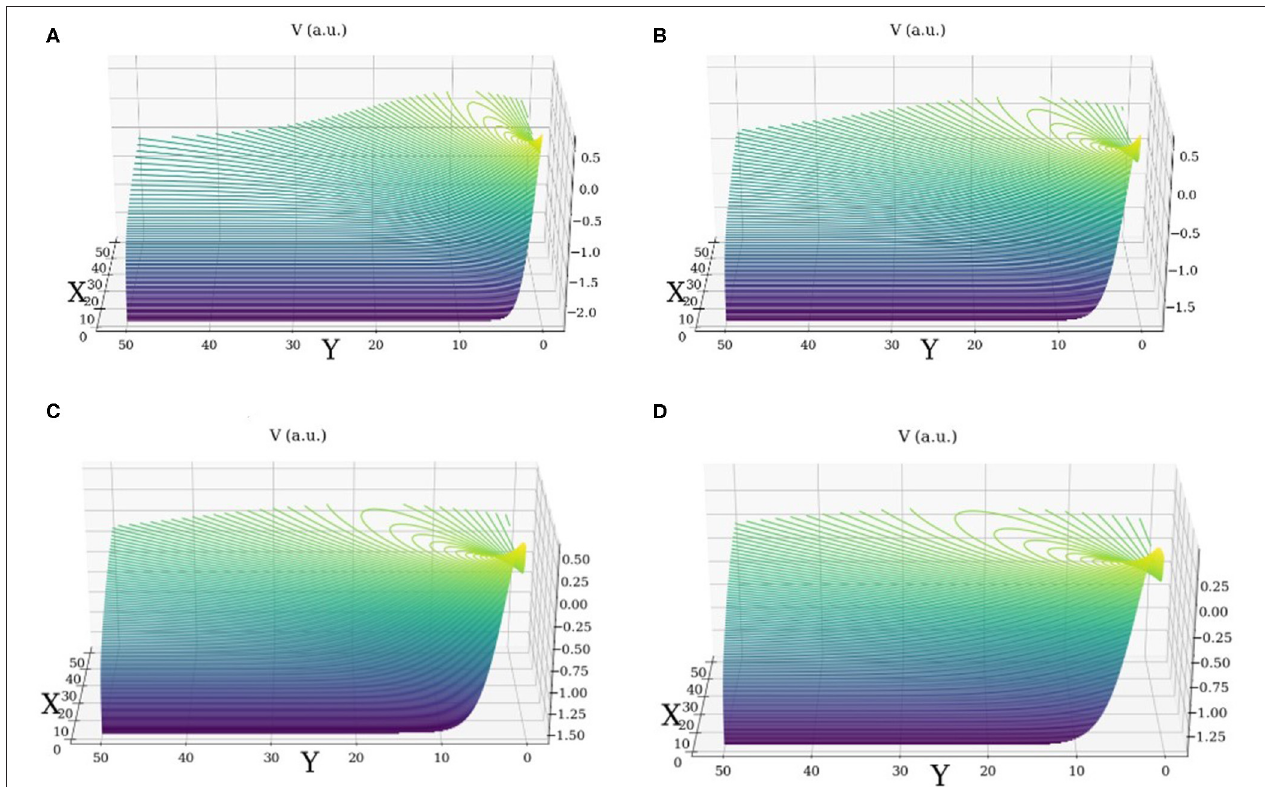
FIGURE 2 | Normalized velocity field V , for θ